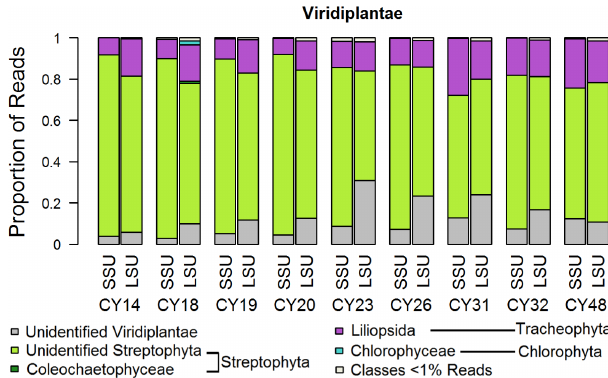
Figure 3. Taxonomic composition of Viridiplantae. Taxonomic classification and proportion of SSU and LSU reads of Viridiplantae at the class